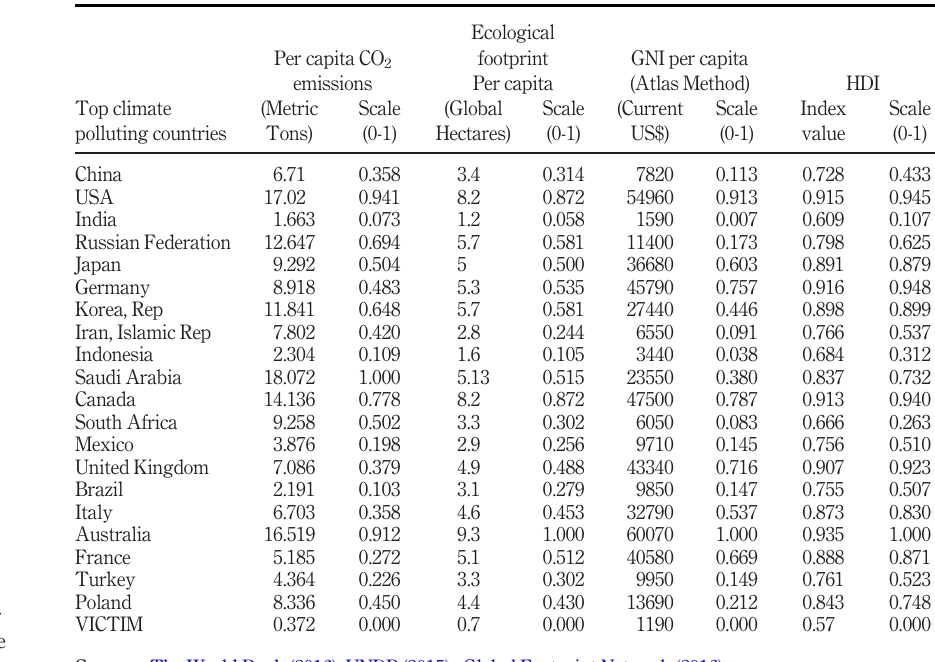
Table III. Scaling the parameters for climate refugee distribution